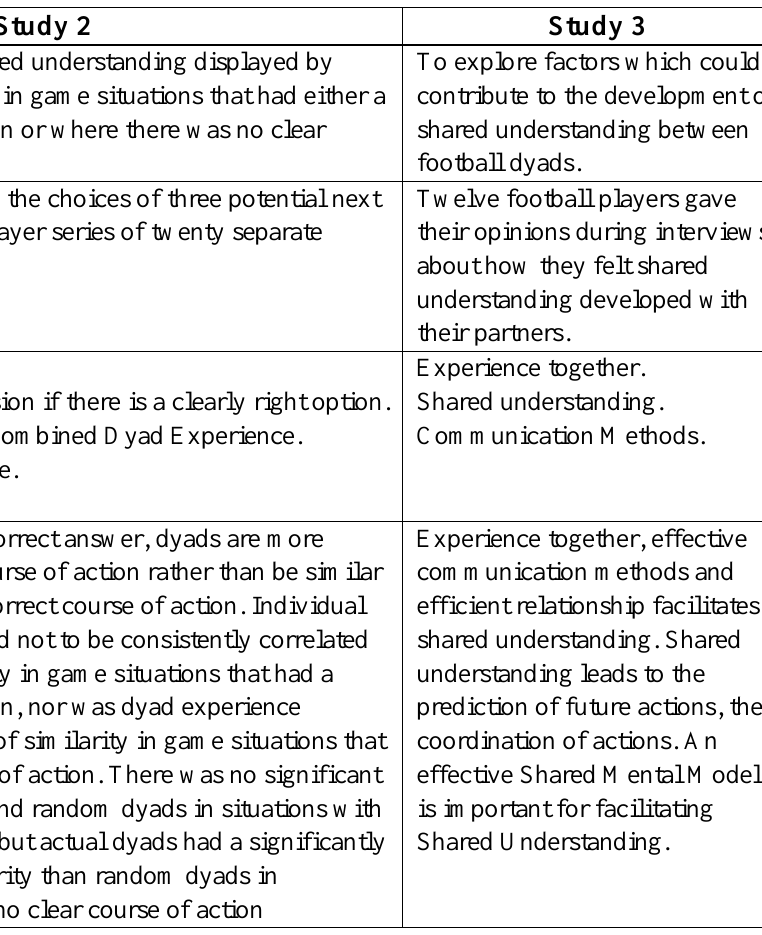
Table 13.1 – Summary of